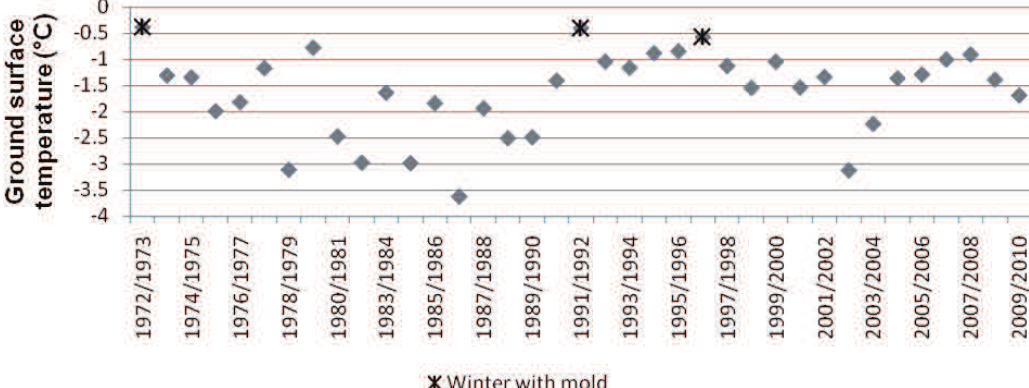
Figur e 5. The mean simulated ground surface temperature for the whole snow cover period during 1972-2010. Three winters with conditions favoring mold growth reported by the reindeer herders marked with stars.